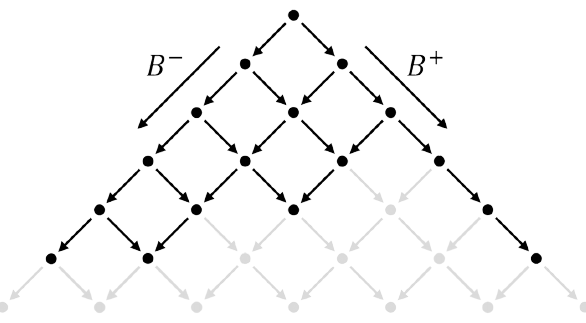
Figure 16: One example of 3 d CCA representation where the black dots representing the operators of this representation fitting in the 2 d grid shown in gray.